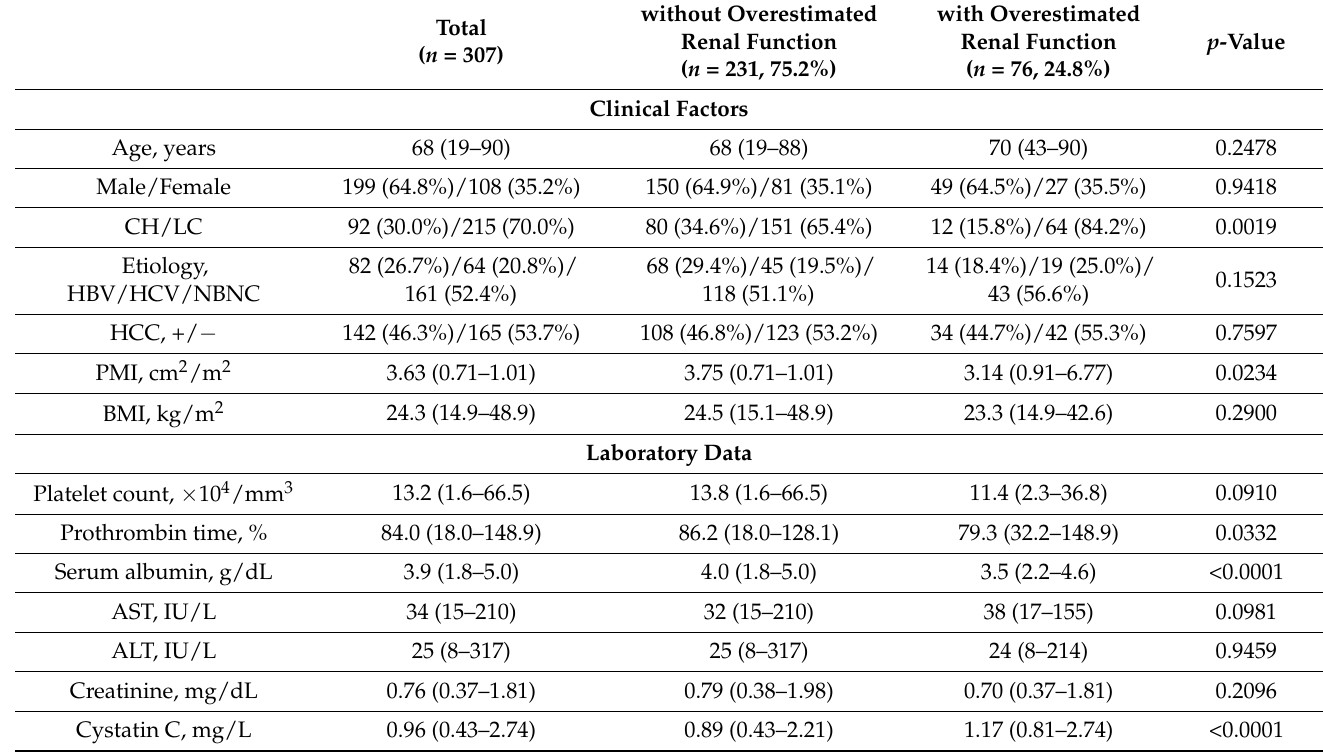
Table 1. Characteristics of patients with or without overestimated renal function.